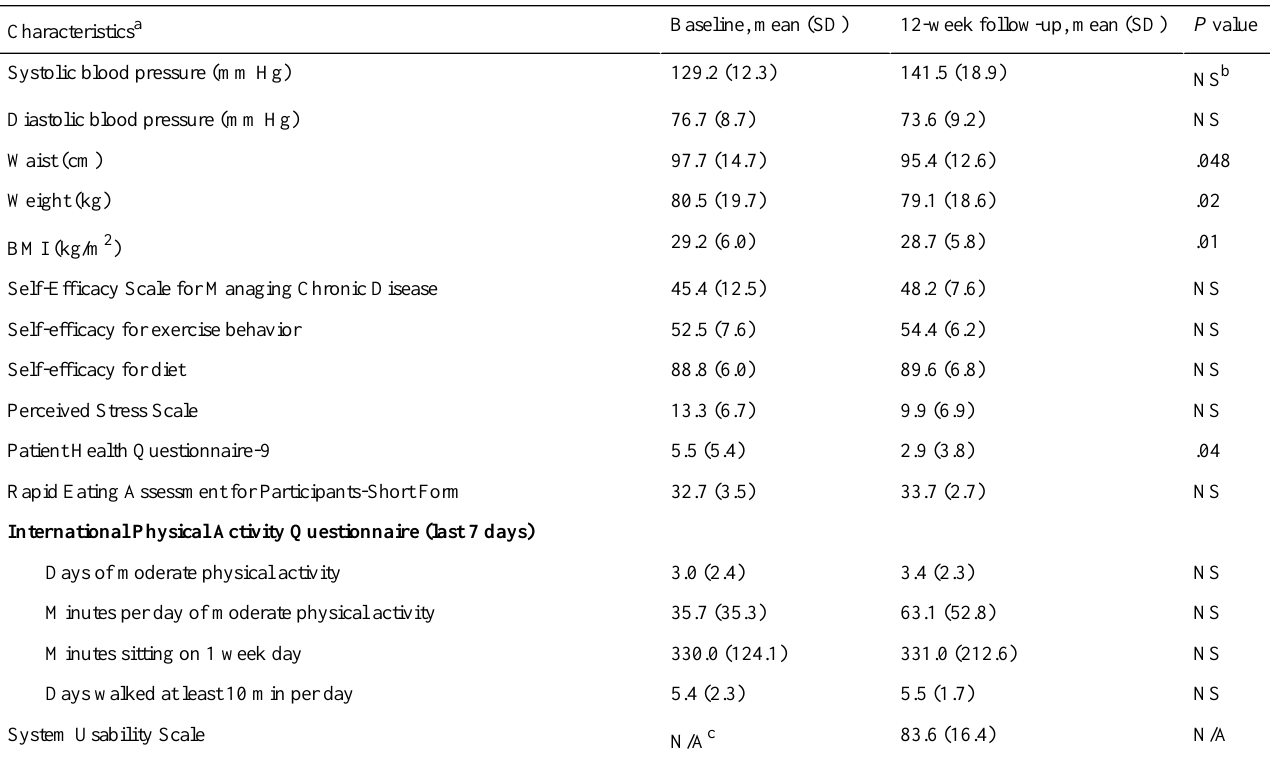
Table 3. Physiological and psychosocial characteristics (n=10).